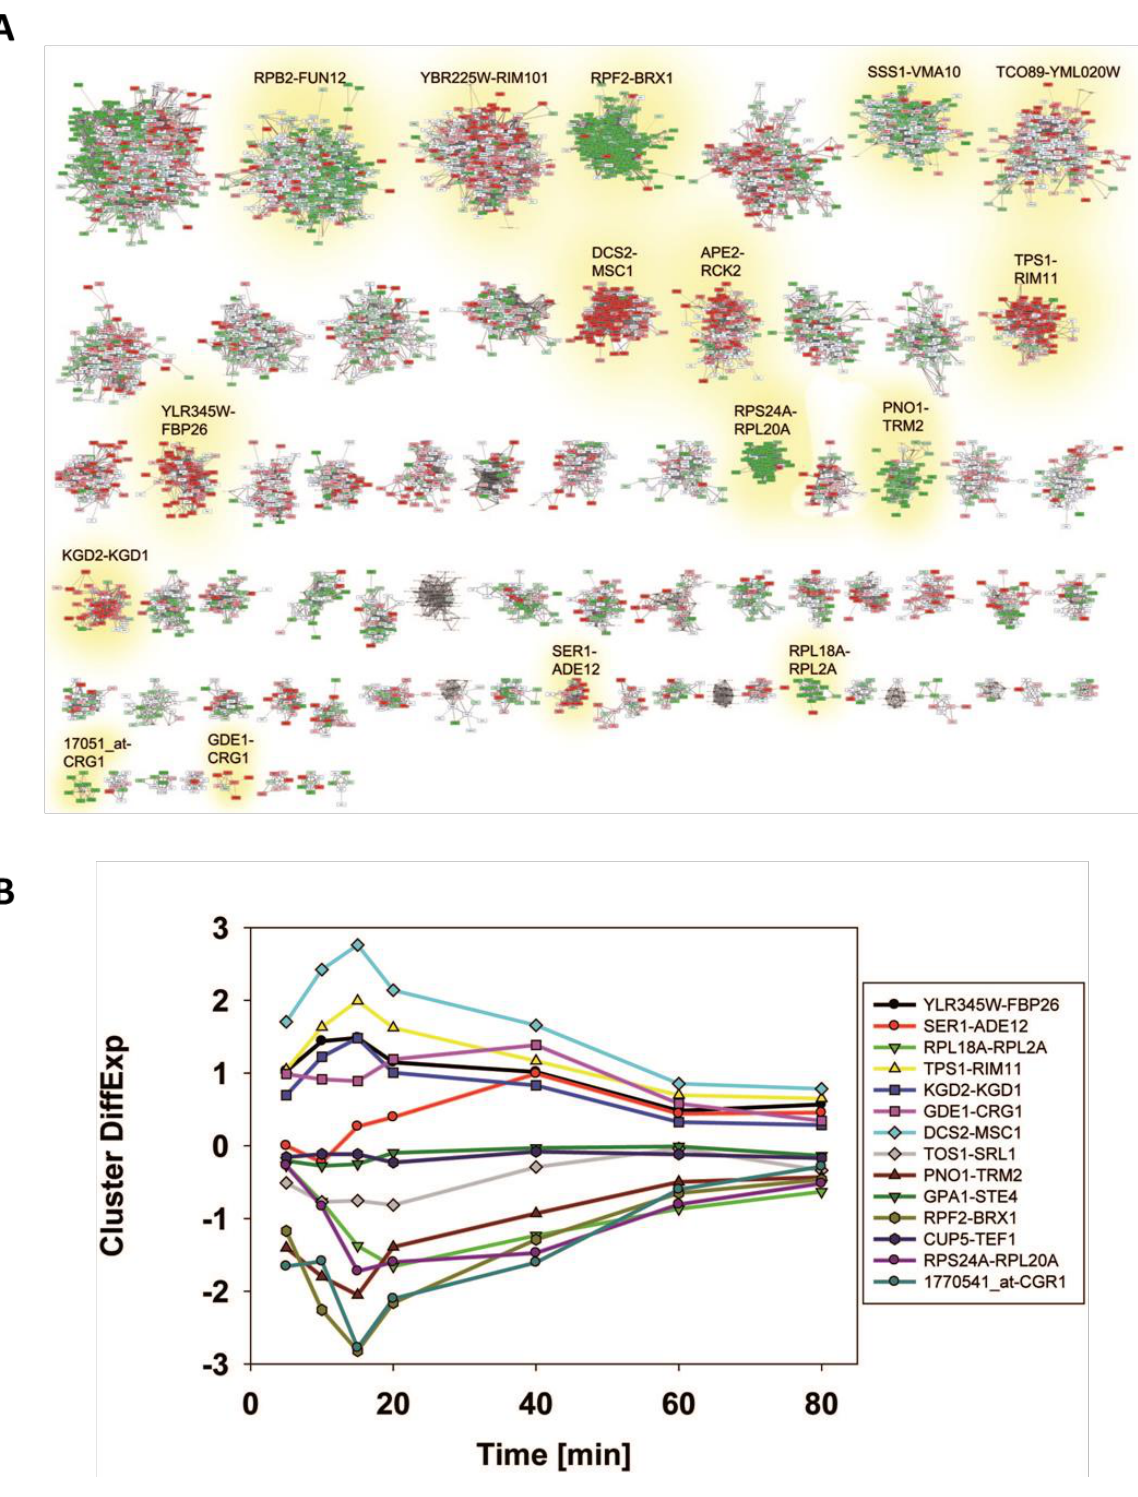
FIGURE 4: Analysis of microarray data sets on the heat-shock response. (A) Response to heat-shock after 40 minutes of recovery as reported by Gasch et al. [39]. Upregulation is indicated in four shadings of red. Downregulation is indicated in four shadings of green. Significantly changed cliques are highlighted with yellow background and labelled. (B) Time-course of the relevant cliques based on the single replicates provided on the SPELL